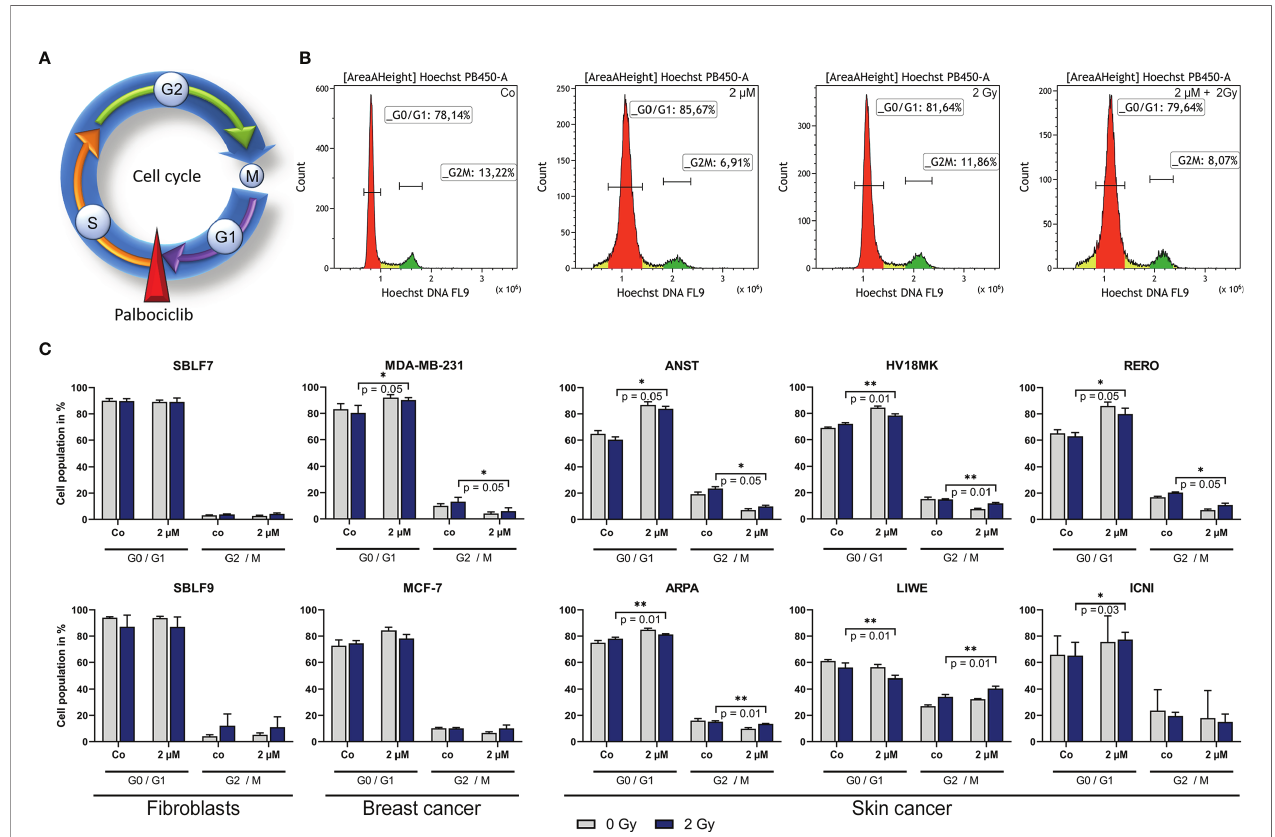
FIGURE 4 | In fl uence of palbociclib on cell cycle of different cell lines. (A) Palbociclib arrest cells in the G1 phase of cell cycle by blocking the S/G1 phase checkpoint. (B) Representative histograms depicting the gating strategy of Hoechst staining (DNA) in breast cancer cell line MCF-7 after treatment (Co/2 µM/2 Gy/2 µM + 2 Gy). (C) Population of cells in the G0/G1 or G2/M phase, respectively. Cells were treated with 2 µM palbociclib, 2 Gy dose irradiation, or a combination of both. Each value represents mean ± SD ( n = 4). Signi fi cance was determined by one-tailed Mann – Whitney U test * p ≤ 0.05, ** p =